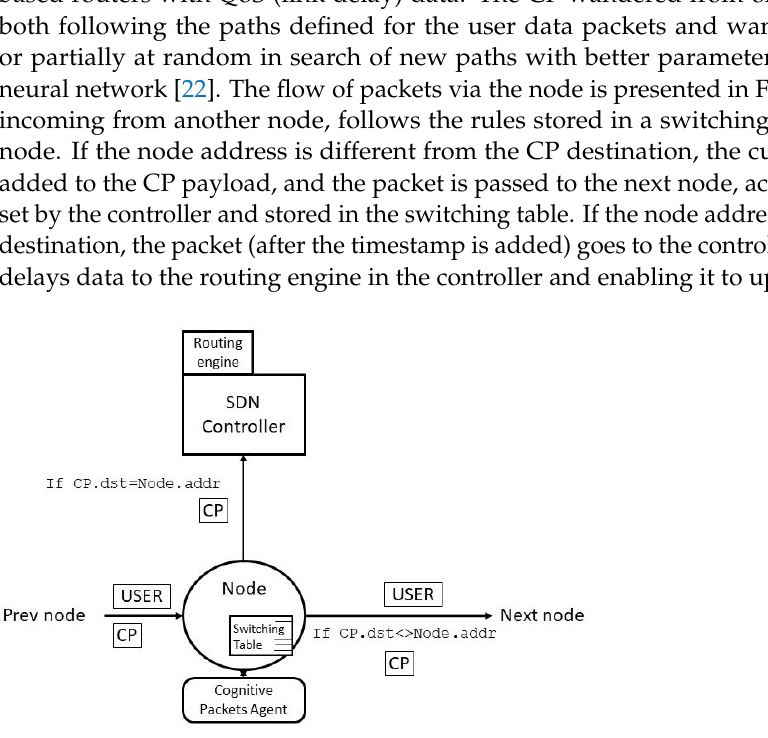
Figure 1. The flow of user and cognitive packets in the